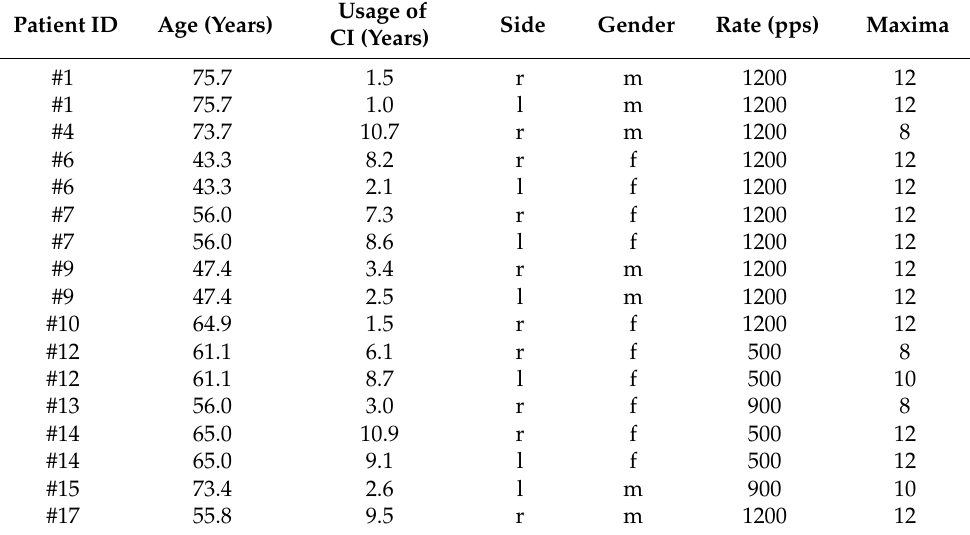
Table 1. Biographical data of